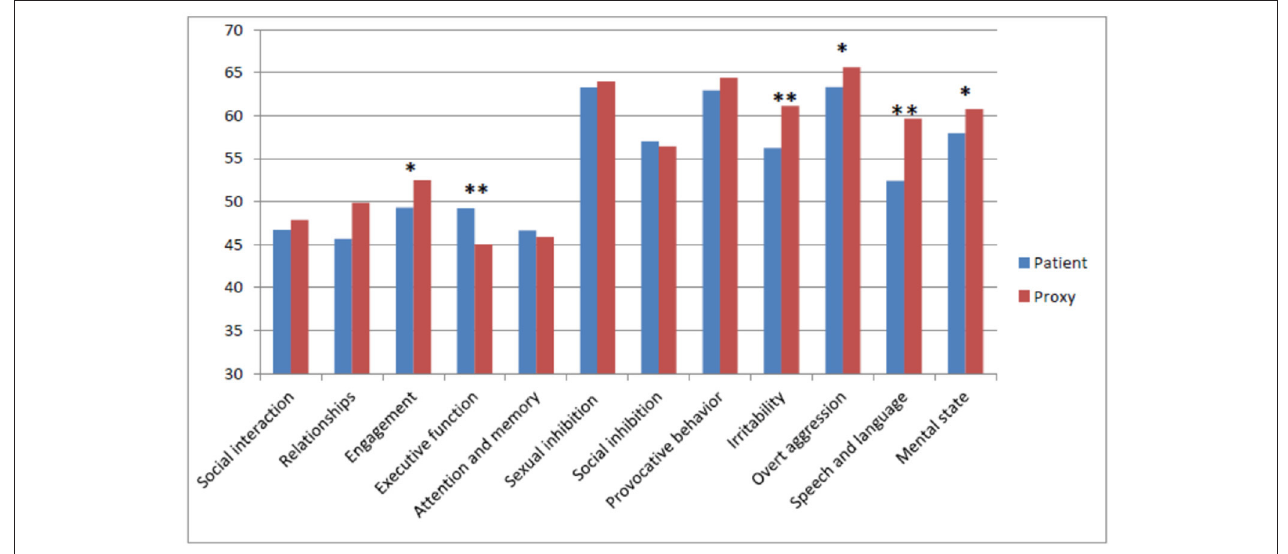
FIGURE 3 | Mean Scores on the subdomains as rated by patients and proxies. Level of significance: * p < 0.05, ** p < 0.05.